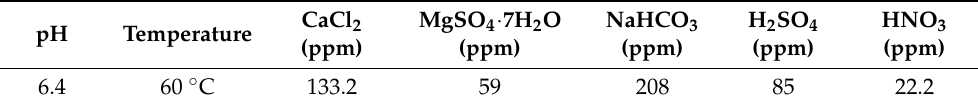
Table 2. Composition of the tested